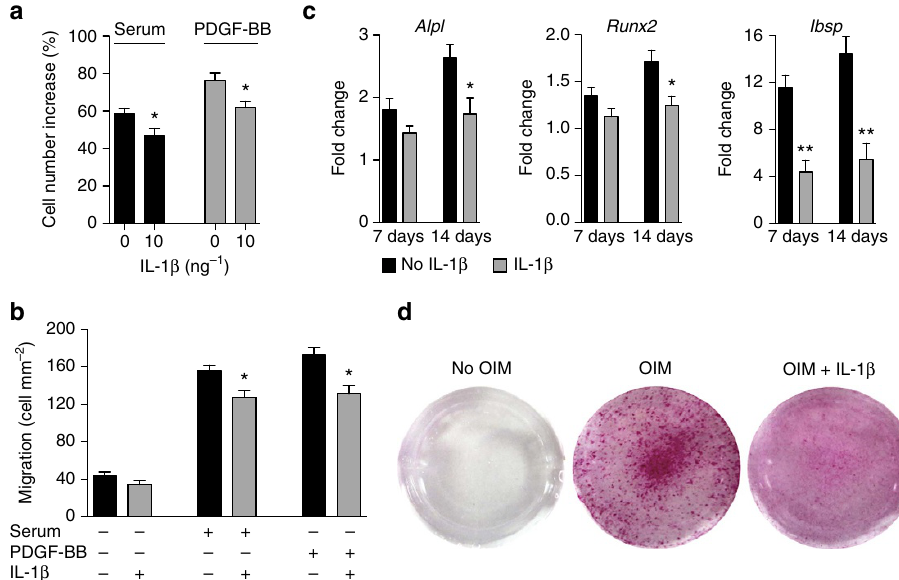
Figure 4 | IL-1 b slightly inhibits proliferation migration and differentiation of osteoblasts. ( a ) Osteoblast proliferation was stimulated with 10% serum or PDGF-BB (10ngml (cid:2) 1 ), in the presence of 5ngml (cid:2) 1 of IL-1 b . After 72h, the cell number increase was measured. Data are means ± s.e.m. ( n ¼ 3). ( b ). Osteoblast migration through a transwell was induced by 10% serum or PDGF-BB (5ngml (cid:2) 1 ), in the presence of IL-1 b (1ngml (cid:2) 1 ). After 6h, the number of cells per square millimetre that passed through the transwell was measured. Data are means ± s.e.m. ( n ¼ 3). ( c ) Osteoblasts in osteogenesis induction medium (OIM) were treated once with IL-1 b (1ngml (cid:2) 1 during 4 days). ( d ) After 28 days, matrix mineralization was revealed with alizarin red staining. Representative wells are shown. For a – c , data are means ± s.e.m. ( n Z 3). * P o 0.05, ** P o 0.01; Student’s t